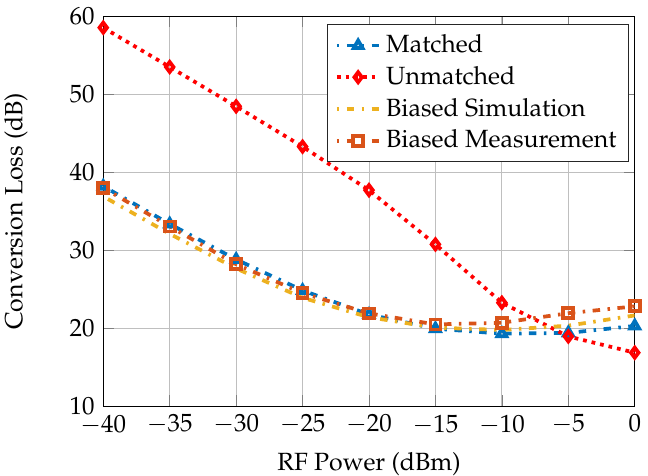
Figure 8. CL variation with input power at 2.45GHz fundamental frequency and a